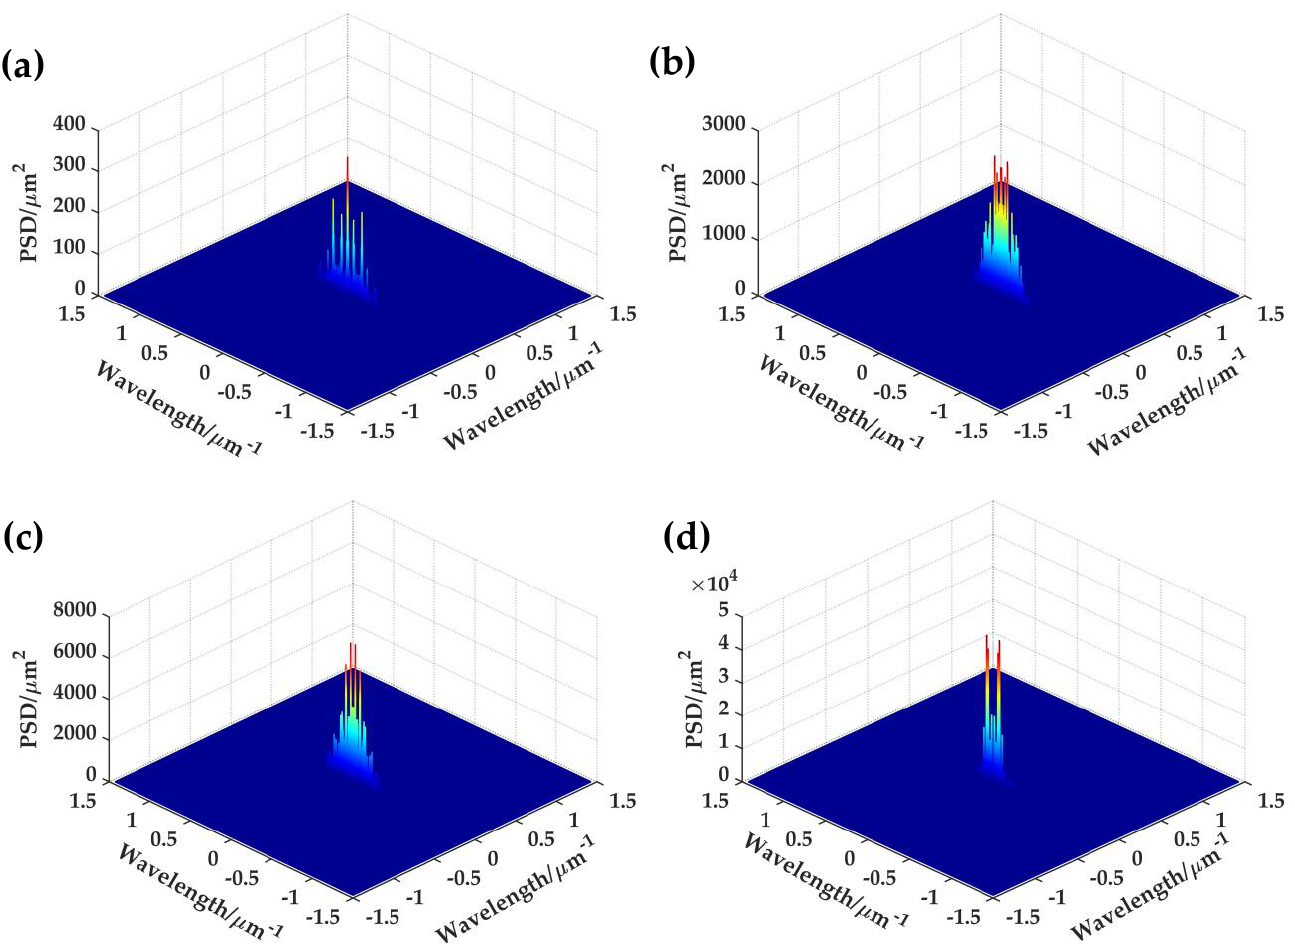
Figure 2. The 2D power spectral density: ( a ) Surface 1; ( b ) Surface 2; ( c ) Surface 3; ( d ) Surface 4.